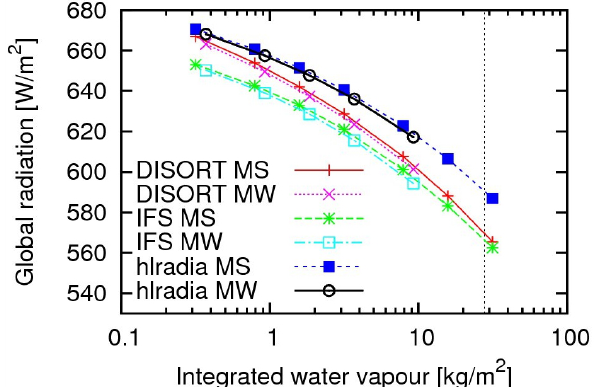
Figure 1. Experiment 1: global radiation as a function of inte- grated water vapour. The results from Kato-DISORT with the “mid- latitude summer” (MS) and “mid-latitude winter” (MW) atmo- spheric profiles are shown with the red and magenta lines, respec- tively. The corresponding results for IFS are shown with green and cyan lines, and the results for hlradia are shown with blue and black lines. The vertical dashed line marks the reference integrated water vapour used in the other experiments.